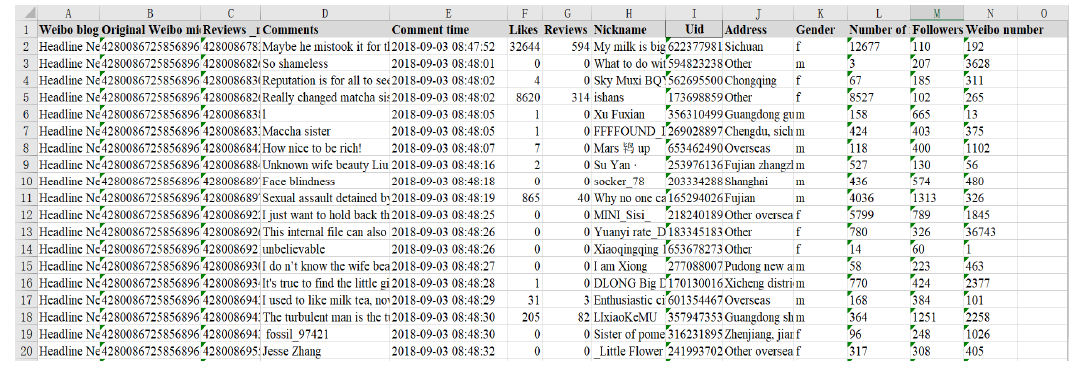
Figure 28. Relevant comments.